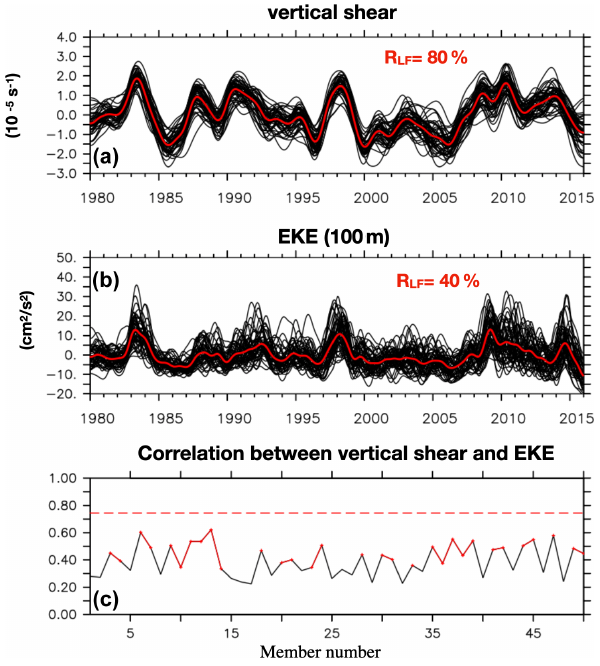
Figure 9. Time series of the vertical shear (10 − 5 s − 1 ) (a) and EKE at 100m (cm 2 s − 2 ) (b) interannual anomalies averaged in the STCC region (28–22 ◦ S, 160–180 ◦ E). In black: values from the 50 mem- bers; in red: values from the ensemble mean. (c) Correlation be- tween the vertical shear and the EKE interannual anomalies for all the members (in black), with the x axis corresponding to the 50 members and the ensemble mean (in dashed red). The correla- tions significantly different from zero at the 95% confidence level are overlaid in red. The ratio R LF of the deterministic variance to the total variance as a percentage is given for the shear and the